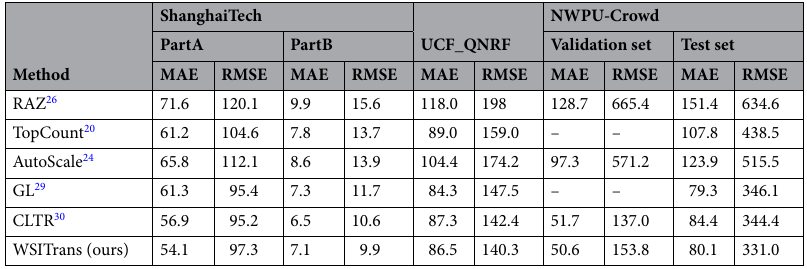
Table 6. Crowd counting performance on the ShanghaiTech, UCF_QNRF, and NWPU-Crowd dataset.